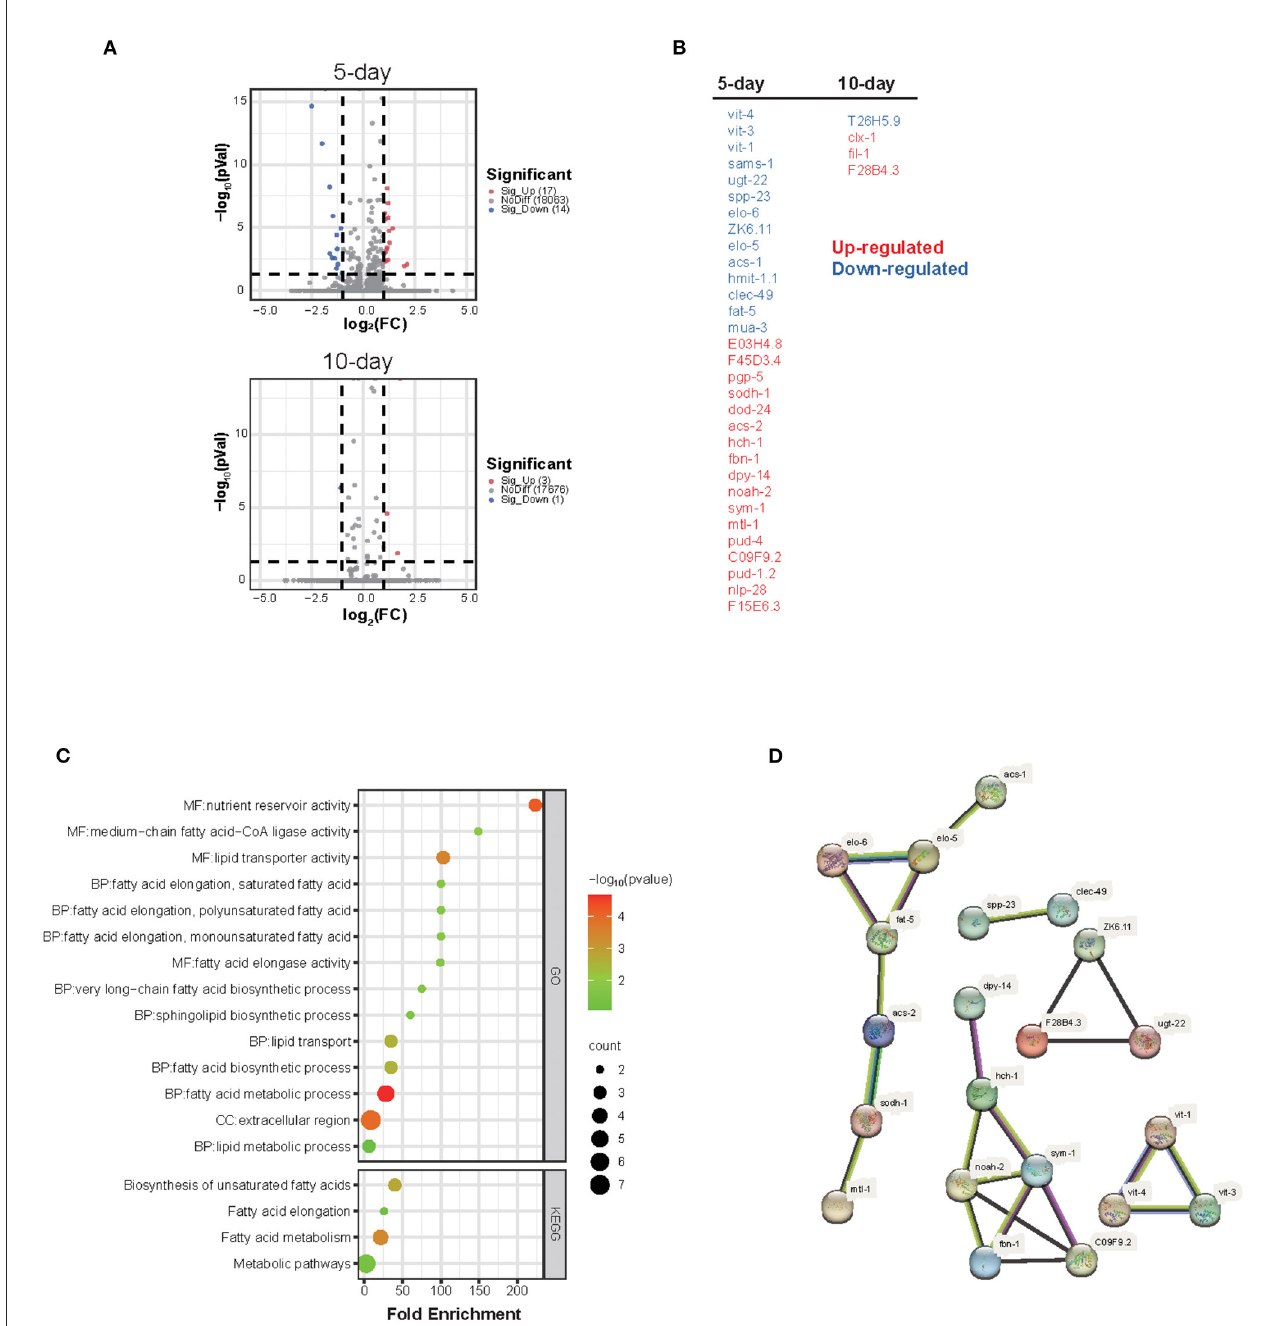
FIGURE2 Global gene expression analysis shows that the homeostasis of lipid transport and metabolism is disturbed by WS-PM 2.5 exposure. Global gene expression of C H WS-PM 2.5 -treated nematodes as well as control nematodes were determined by RNA-Sequencing technology. (A) Volcano plots show the numbers of DEGs between treated and control nematodes at the 5th day (A) or the 10th day (B) during the C H WS-PM 2.5 exposure. (B) All DEGs after 5 d- or 10 d-treatment are listed in two columns. (C) DEGs induced by C H WS-PM 2.5 exposure at the 5th day or 10th day were combined, on which GO term/KEGG pathway term functional annotation and enrichment analysis were performed. (D) Protein-protein interaction netowrk between proteins of DEGs was predicted by using STRING database.